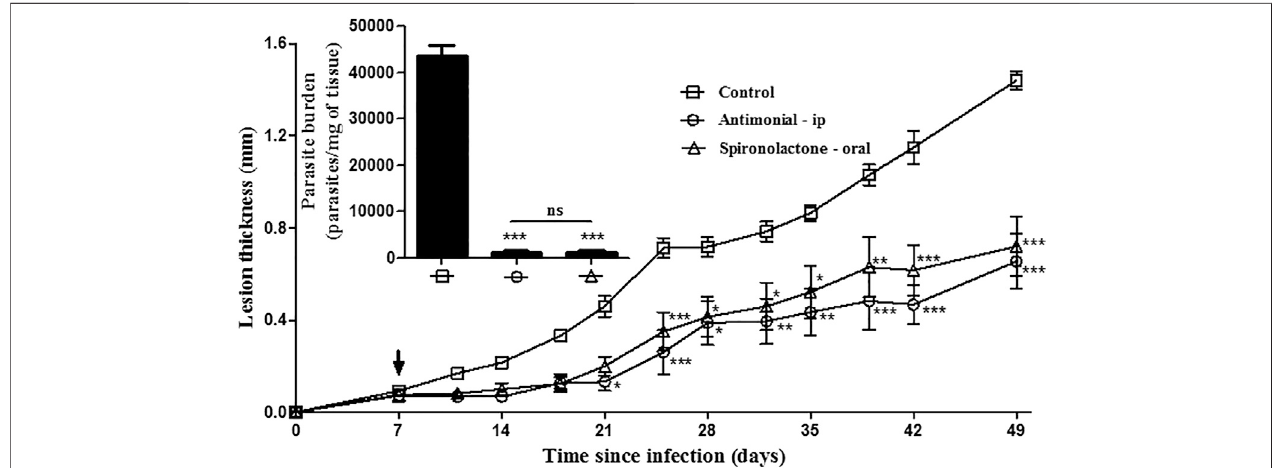
FIGURE 2 | Ef fi cacy of oral spironolactone against murine cutaneous leishmaniasis. BALB/c mice were infected subcutaneously in the right ear with 2 × 10 6 promastigotesof L.amazonensis .Allanimalsweretreated fi vedays/weekforsixweeks.Spironolactoneat8.8 mg/kg/daywasdiluted inPBScontaining2%DMSOand was given orally; meglumine antimoniate (30 mg/kg/day of the Sb 5+ ) or PBS containing 2% DMSO was injected intraperitoneally in the right lower quadrant of the abdomen. The lesion development was monitored two times a week, measuring the infected ear with a caliper. At the end of the treatment, the animals were euthanized, and the parasite load was estimated by limiting dilution analysis (insert). Data are represented as the means ± standard error of four animals per group. * p < 0.05, ** p < 0.01, and *** p < 0.001 in treated groups x control group.